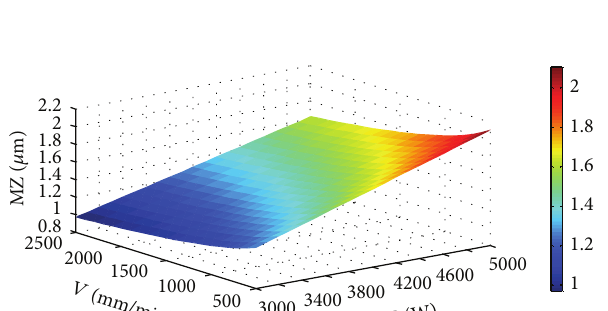
Figure 14: Response surface plot of MZ depth with laser cutting speed and laser beam diameter ( 𝑃 = 3 000 W).